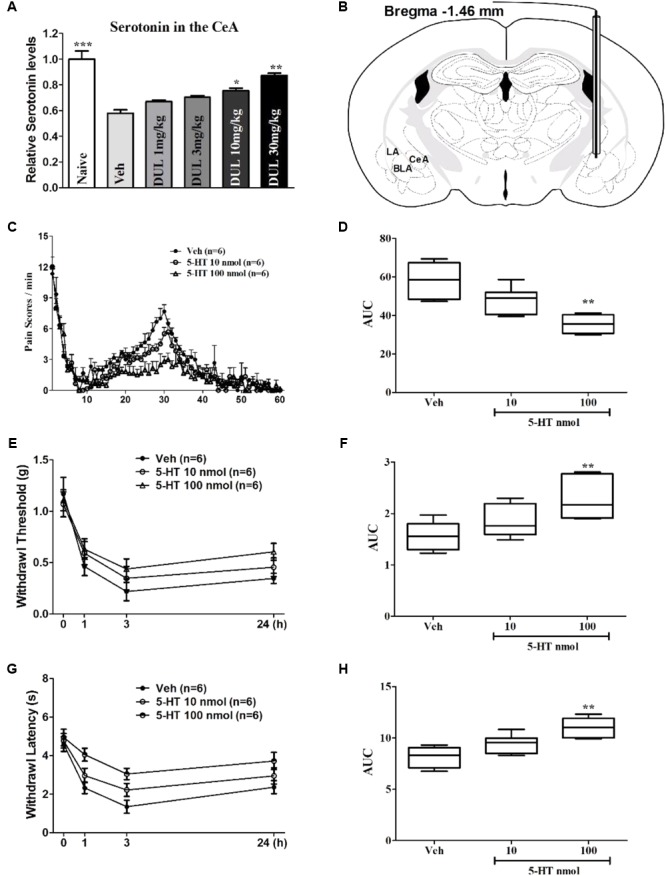
The roles of 5-HT in the CeA on the formalin injection-induced spontaneous pain response and secondary hyperalgesia. DUL dose-dependently lightened the formalin injection-induced reductions of serotonin levels in the contralateral CeA (A). The diagram image in (B) showed that the cannular was implanted into the CeA (Bregma –1.46 mm). Local infusion 5-HT dose-dependently decreased the formalin injection-induced spontaneous pain responses (C,D). The reductions of mechanical (E,F) and thermal (G,H) hyperalgesia after formalin injection were dose-dependently alleviated with CeA 5-HT injection. ∗P < 0.05, ∗∗P < 0.01, One-way ANOVA, Dunnett’s post hoc test, n = 6 in each group.